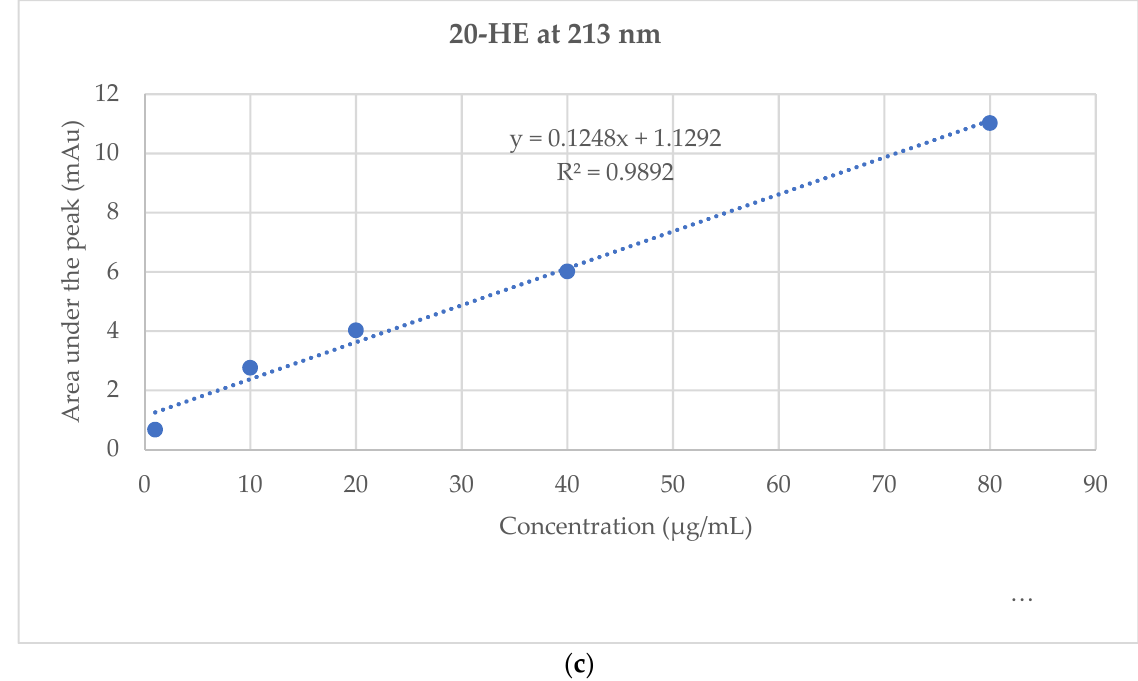
Figure 2. Standardization of TEAD: ( a ) HPLC chromatogram of TEAD at 213 nm. ( b ) UPLC chro- matogram of the isolated 20-HE. ( c ) Calibration curve of the isolated 20-HE.